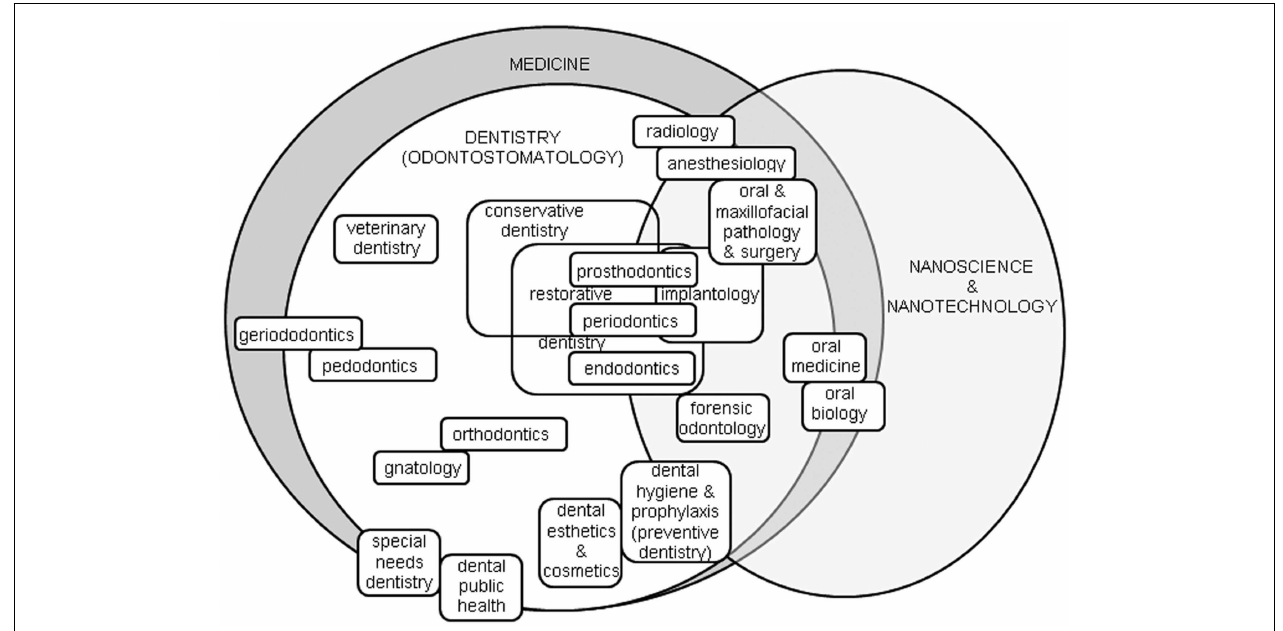
FIGURE 1 |The dental arena, roughly contained in the area of medicine, and its specialties most likely connected to the advances in nanoscience and nanotechnology